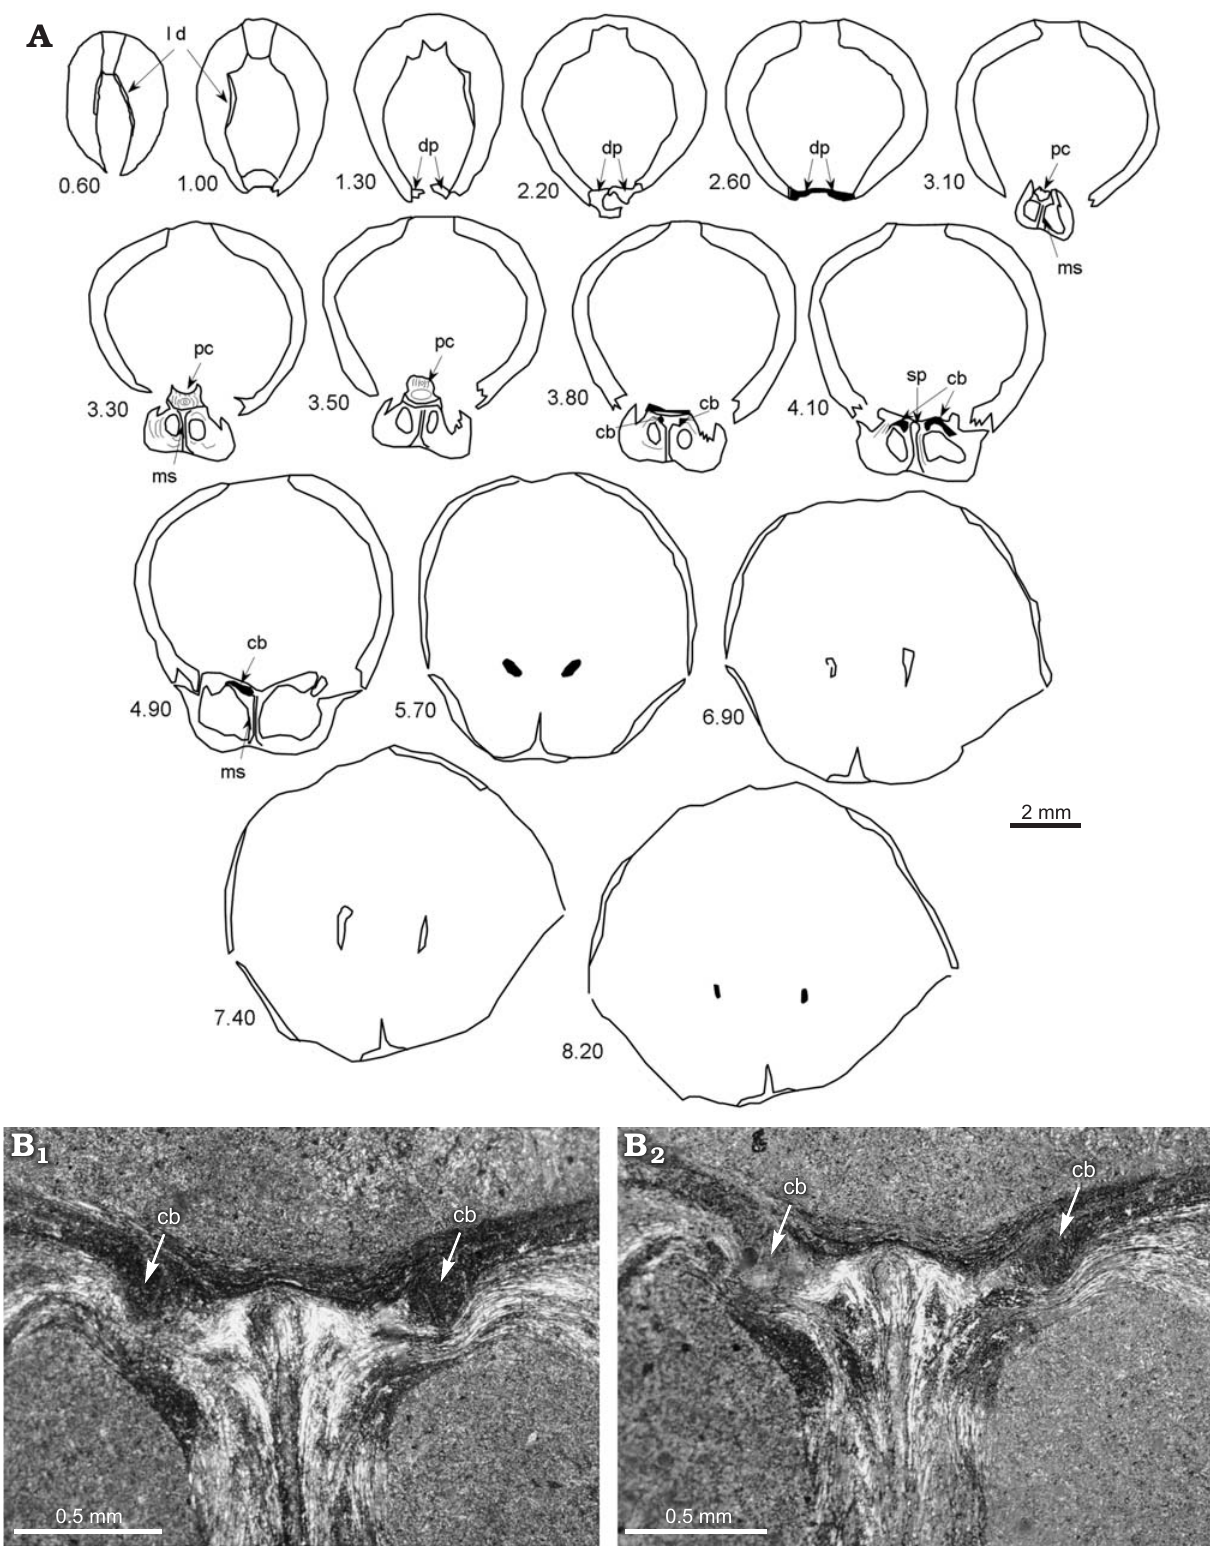
Fig. 4. Internal structure of zeillerid brachiopod Misunithyris goyi gen. et sp. nov. (BQ-AH2.2) from the lower Ladinian of the South-Iberian Triassic platform, the Arroyo Hurtado section. A . Transverse serial sections through the specimen (distance from the beak in mm) . B . Microphotographs of acetate peels showing the hinge plates-crural bases relationship: crural bases are located in the ventral part of the hinge plates but a dorsal thickening emerges towards an early dorsal development. Section at 4.10 mm (B 1 ) and 4.30 mm (B 2 ) from the apex. Abbreviations: cb, crural bases; dp, deltidial plates; ld, dental lamellae; ms, median septum; pc, cardinal process; sp, septalium.